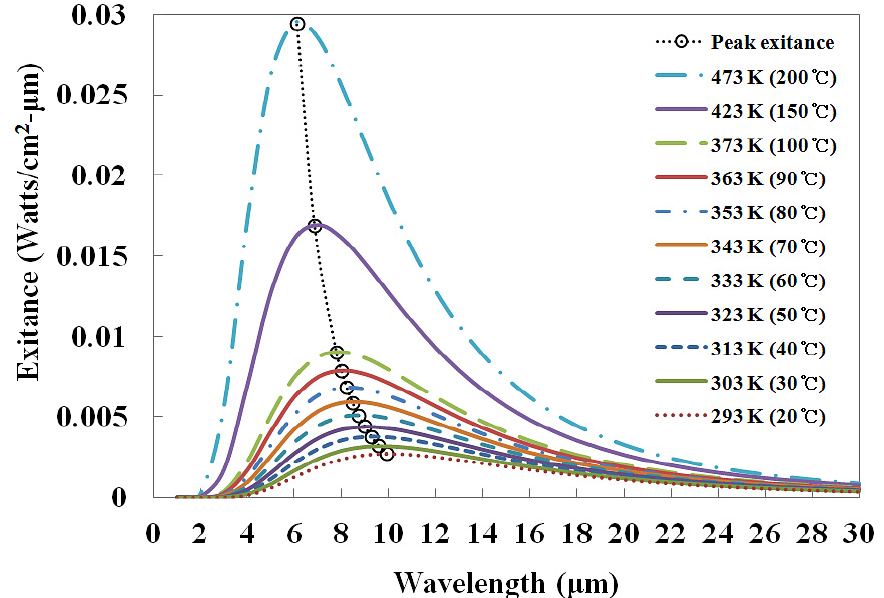
Figure 1. Relationship between the spectral exitance and the wavelength for various temperatures of a blackbody